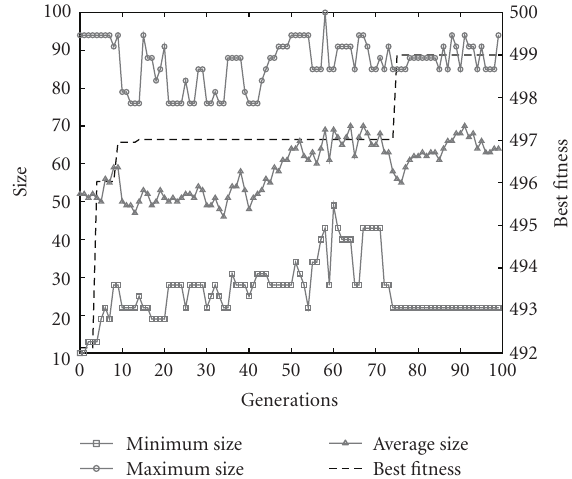
Figure 19: Parameter optimization Experiment 5: chromosome sizes and best fitness.